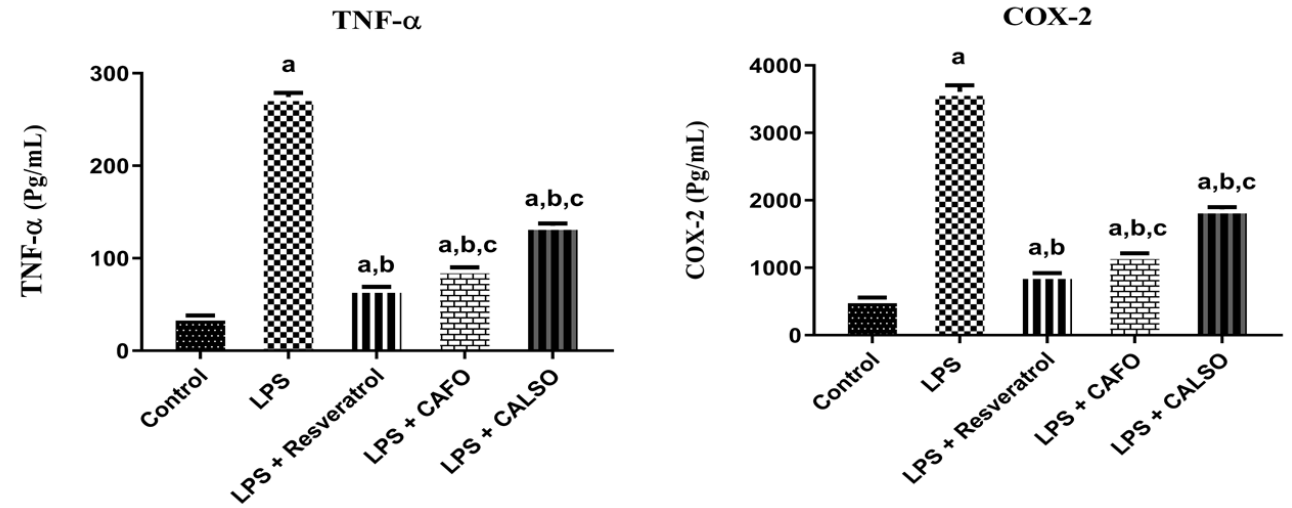
Figure 4. Effect of essential oils on COX-2 and TNF- α level s in LPS-induced inflammation in RAW264.7 cells. Data are expressed as means ± SEM ( n = 3), and analyzed by using one-way ANOVA followed by Tukey – Kramer as the post-ANOVA test. a Significantly different from the value of the control group at p < 0.05. b Significantly different from the value of the LPS group at p < 0.05. c Significantly different from the value of the LPS + resveratrol group at p < 0.05. LPS: Lipopolysaccharides; CAF: C. anthemoides flower essential oil; CALSO: C. anthemoides leaves and stem essential